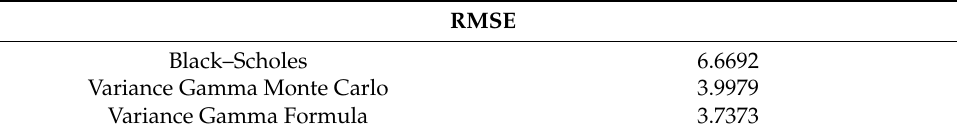
Table 2. Root Mean Square Error.